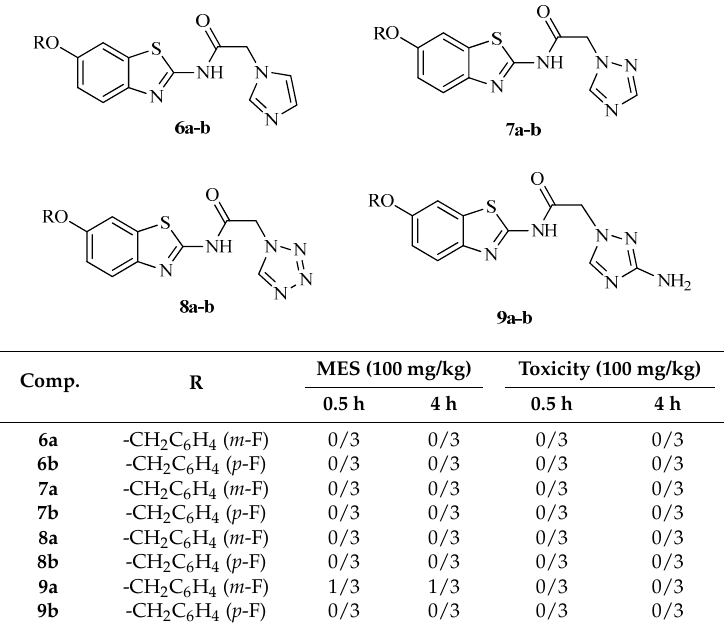
Molecules 2016 , 21 , 164 Table 3. Anticonvulsant activities of compounds 6 , 7 , 8 , and 9 in MES test. Table 3. Anticonvulsant activities of compounds 6 , 7 , 8 , and 9 in MES test.